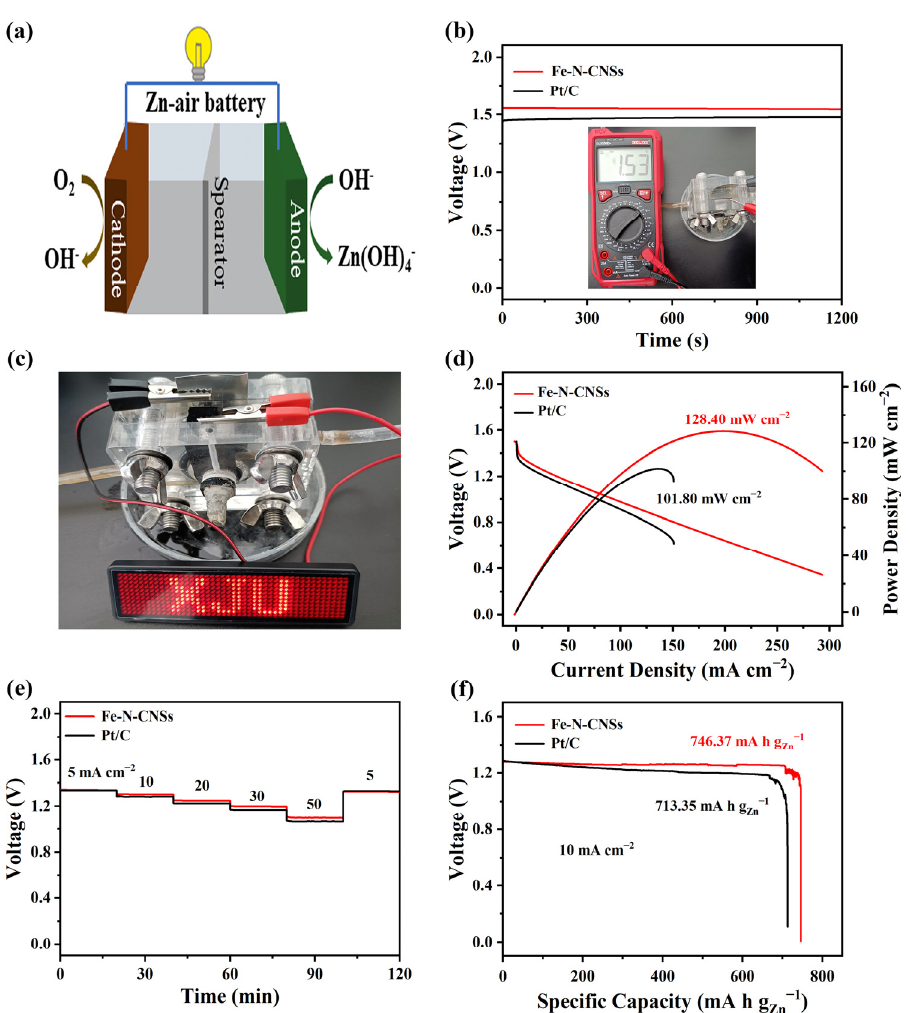
Figure 4. ( a ) Schematic diagram of ZAB. ( b ) OCV of two ZABs. ( c ) The photograph of the LED panel powered by the Fe-N-CNSs-based ZAB. ( d ) Discharging LSV and power density curves, ( e ) discharge curves of two materials from 5 to 50 mA cm − 2 , and ( f ) the speci fi c capacity of two ZABs.